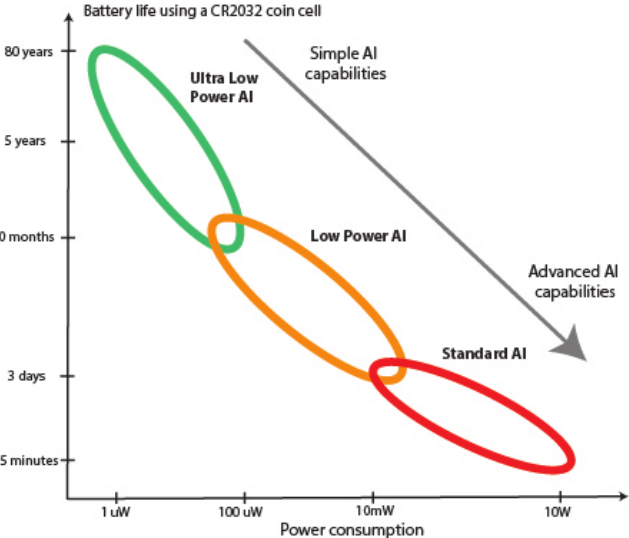
Figure 5. Different types of embedded AI according to their power